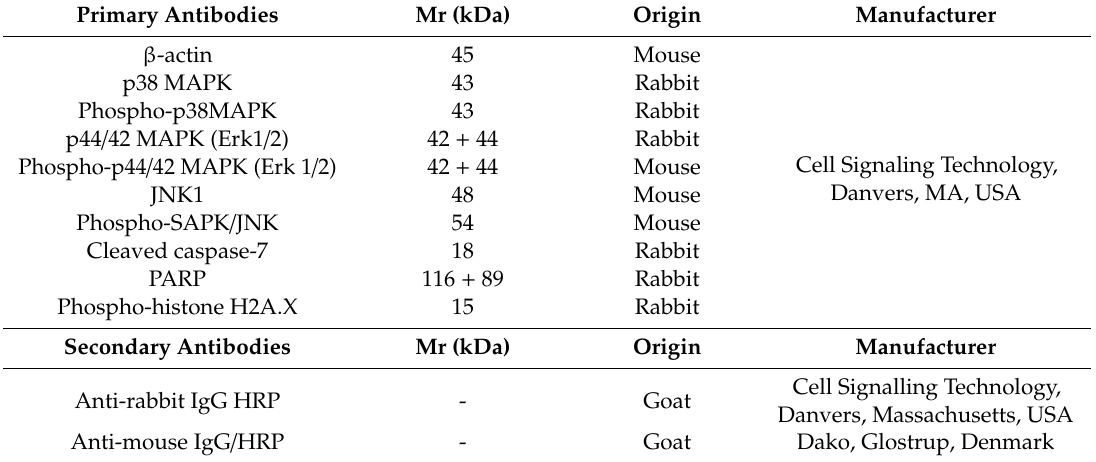
Table 2. List of Western blot